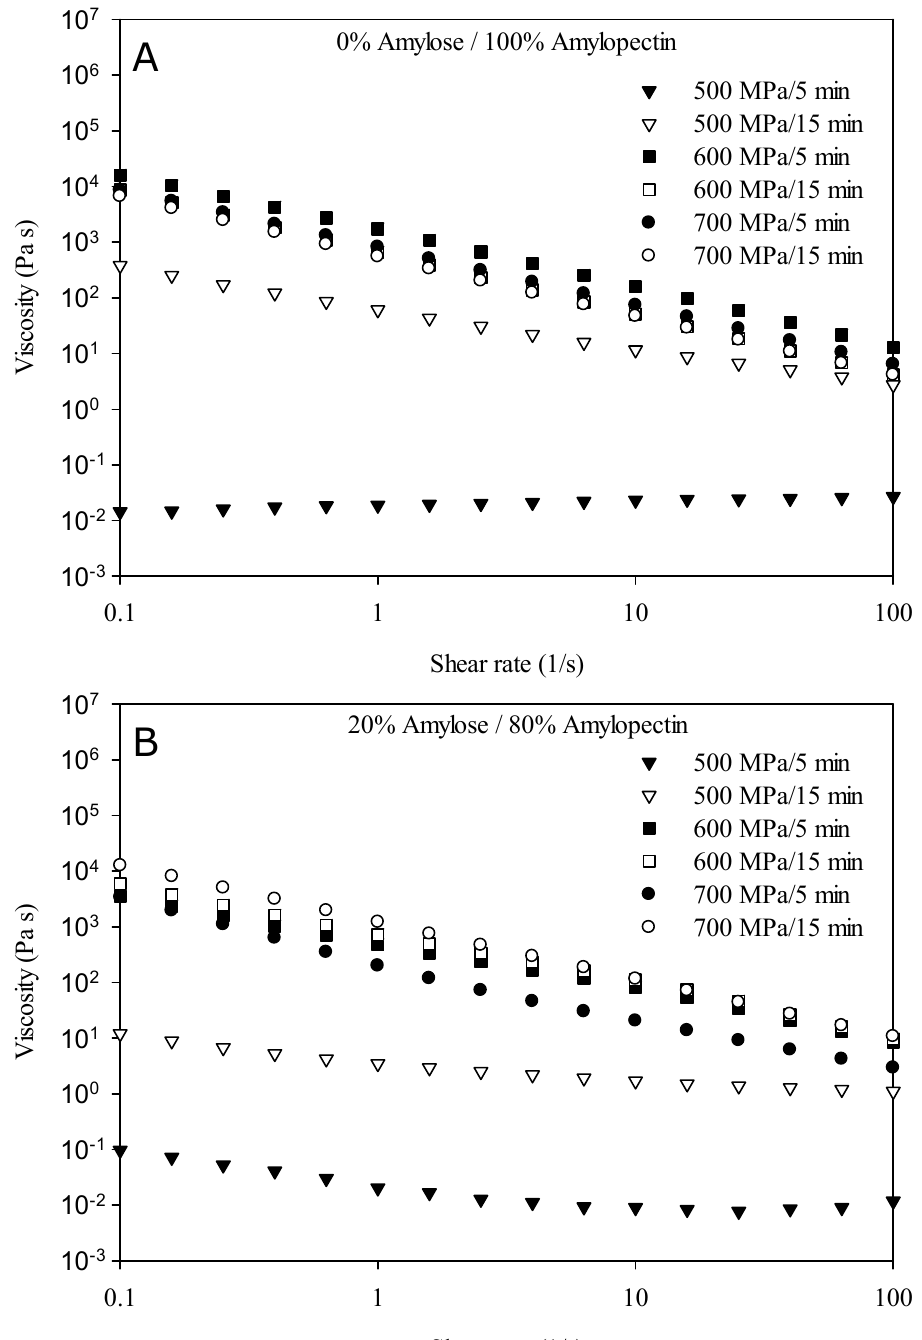
Figure 5. Flow behavior of corn starch HPP hydrogels with different amylose/amylopectin content, ( A ) waxy corn starch; ( B ) normal corn starch. Pressure levels: 600 and 700 MPa; treatment time: 5 and 15 min.